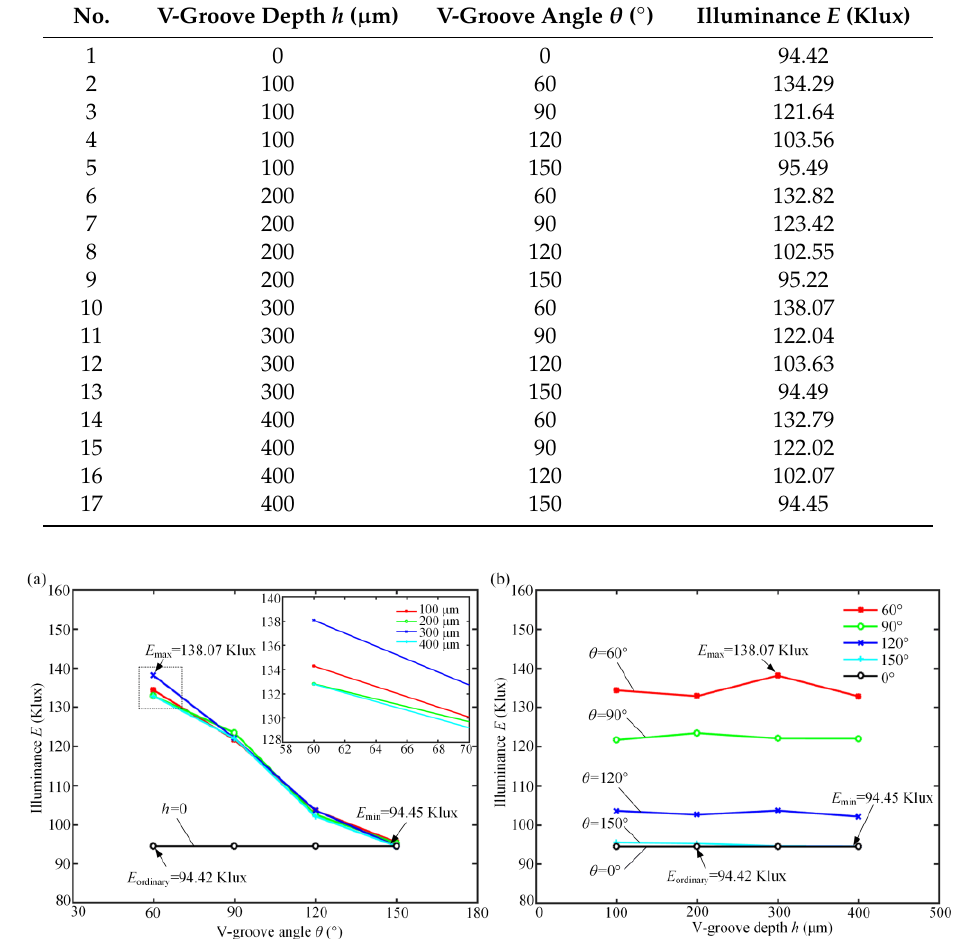
Figure 3. The simulated illuminance E as influenced by the designed V-groove structure parameters: ( a ) V-groove angle θ ; ( b ) V-groove depth h .